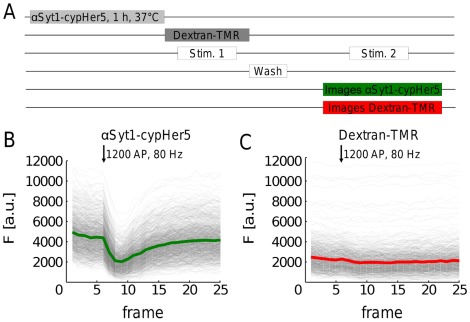
Dextran-TMR cannot be released from synaptic terminals by exocytosis.(A) Experimental procedure. Functional synapses of rat hippocampal neurons were fluorescently labelled with αSyt1-cypHer5. Dextran-TMR was subsequently loaded with 1200 AP, 80 Hz (Stim. 1). After removing extracellular dextran-TMR (wash), images in the Cy5- and TRITC channels were acquired during a second electrical stimulation with 1200 AP, 80 Hz (Stim 2). (B) αSyt1-cypHer5 fluorescence intensity over time for a representative experiment (>900 synapses). A.u., arbitrary units. (C) The corresponding dextran-TMR fluorescence intensity over time during the second stimulation was unaltered by the electrical stimulation. A.u., arbitrary units.